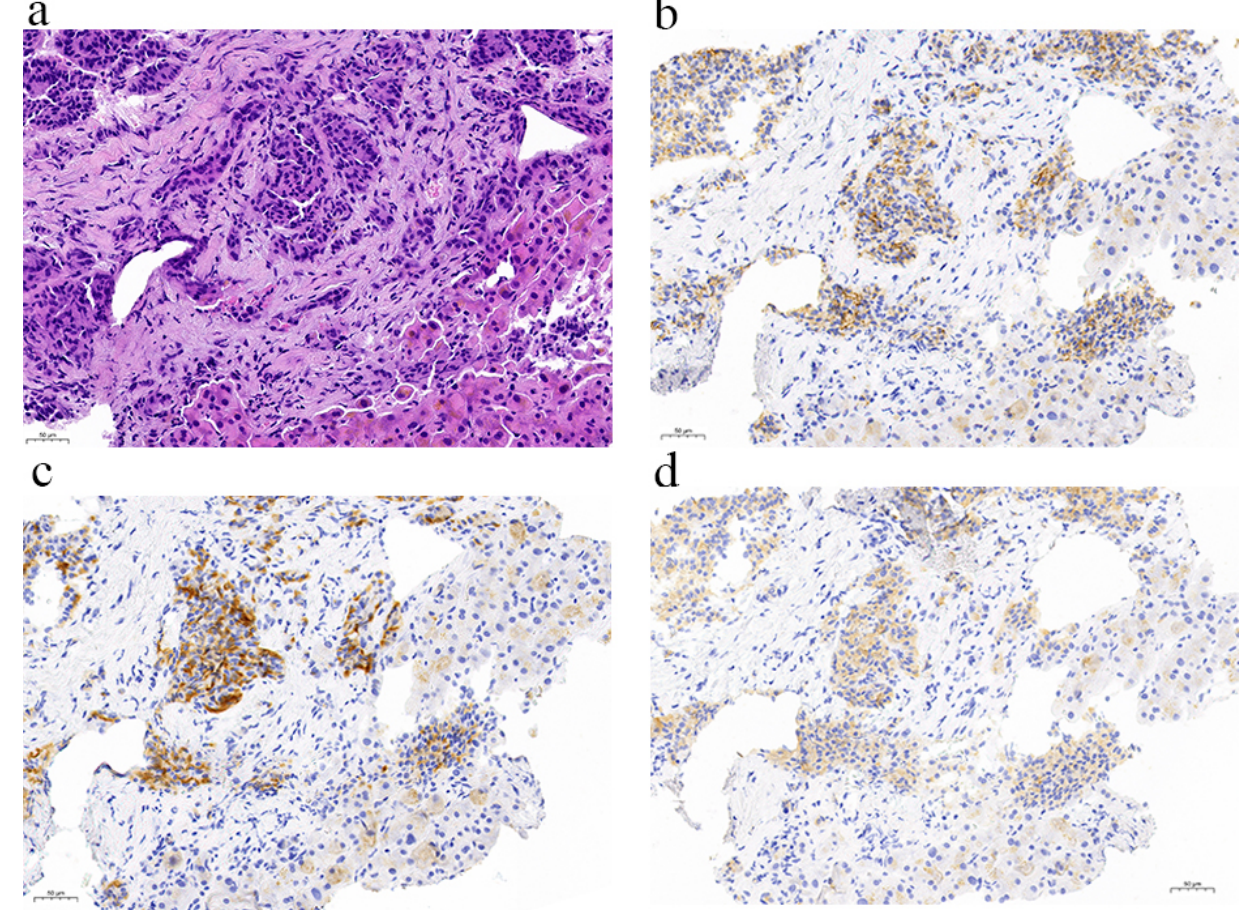
Fig. 1. Metastasis of an adenocarcinoma of “unknown primary” in the liver. (a) Hematoxylin eosin. (b) CD56. (c) Chromogranin A. (d) Synaptophysin staining. Positivity for all neuroendocrine markers determined the neuroendocrine feature. The primary tumour is a de novo small cell neuroendocrine cancer of the